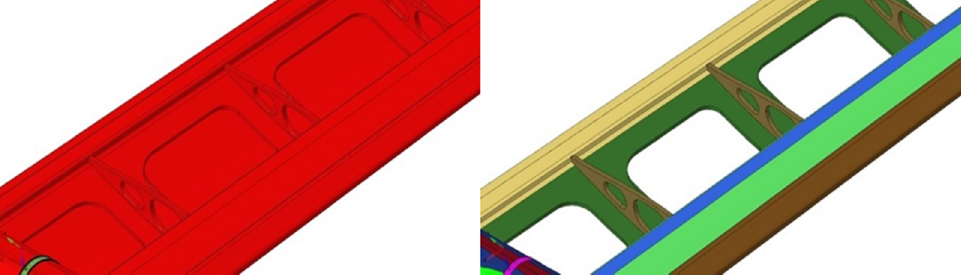
Figure 9. An example of the simplification and segmentation process. On the left is the model before the process, and the right is the model after the process.